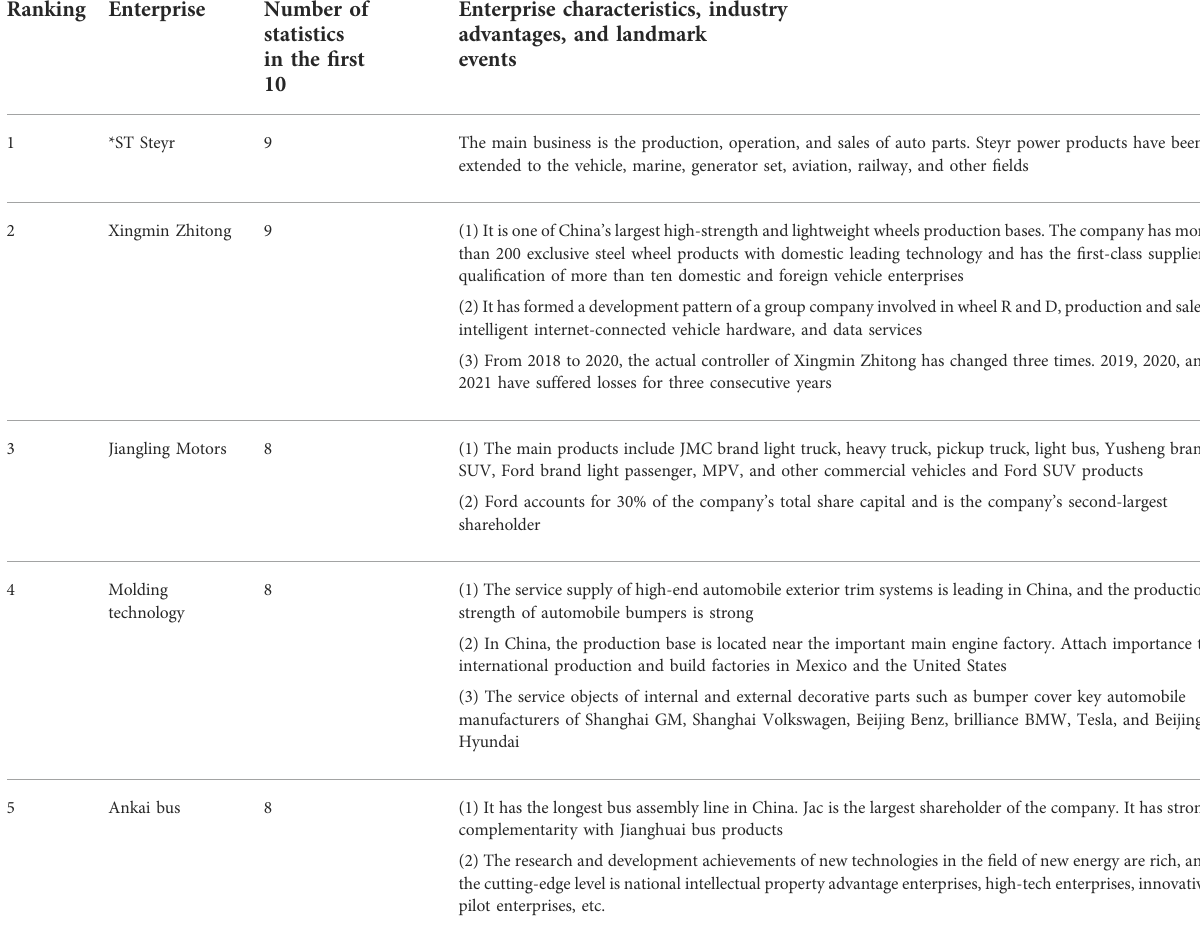
TABLE 5 Statistics of the top 10 network clustering coef fi cients of China ’ s auto fi nance market from 2012 to